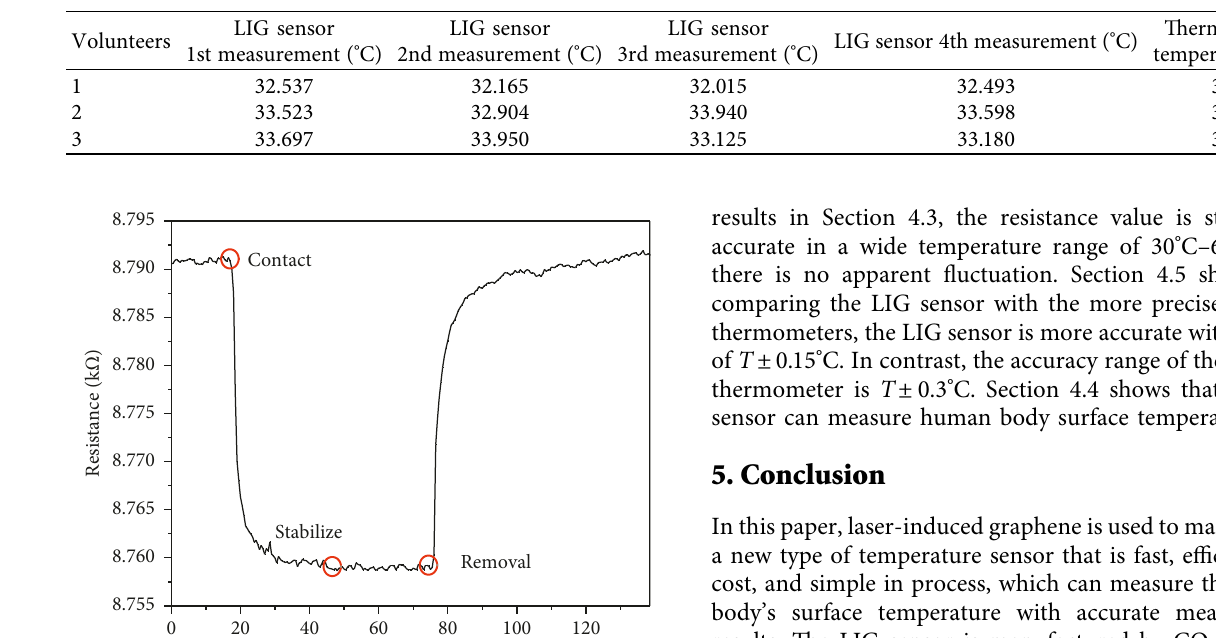
Table 1: Experimental results of the LIG sensor.